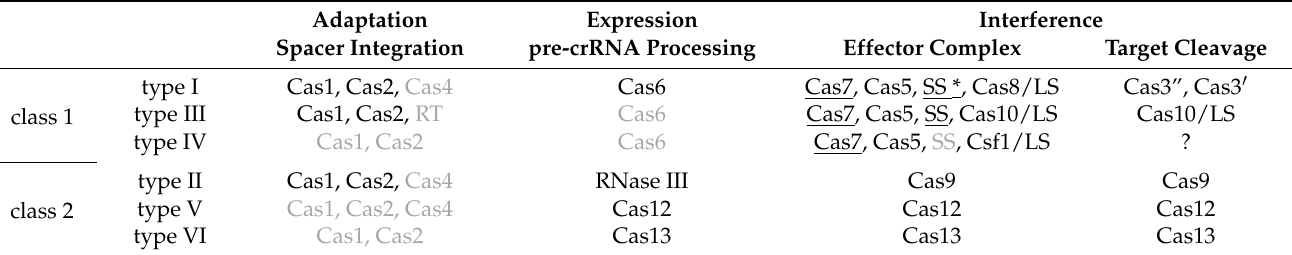
Table 2. Cas protein association with CRISPR functional steps in type I–VI systems. An asterisk represents that protein being potentially fused to a large subunit in some subtypes. Underlined proteins are present in multiple copies. Proteins colored in gray are dispensable or missing in some subtypes or variants. Abbreviations: LS, large subunit; RT, reverse transcriptase; SS, small subunit; ?, unknown